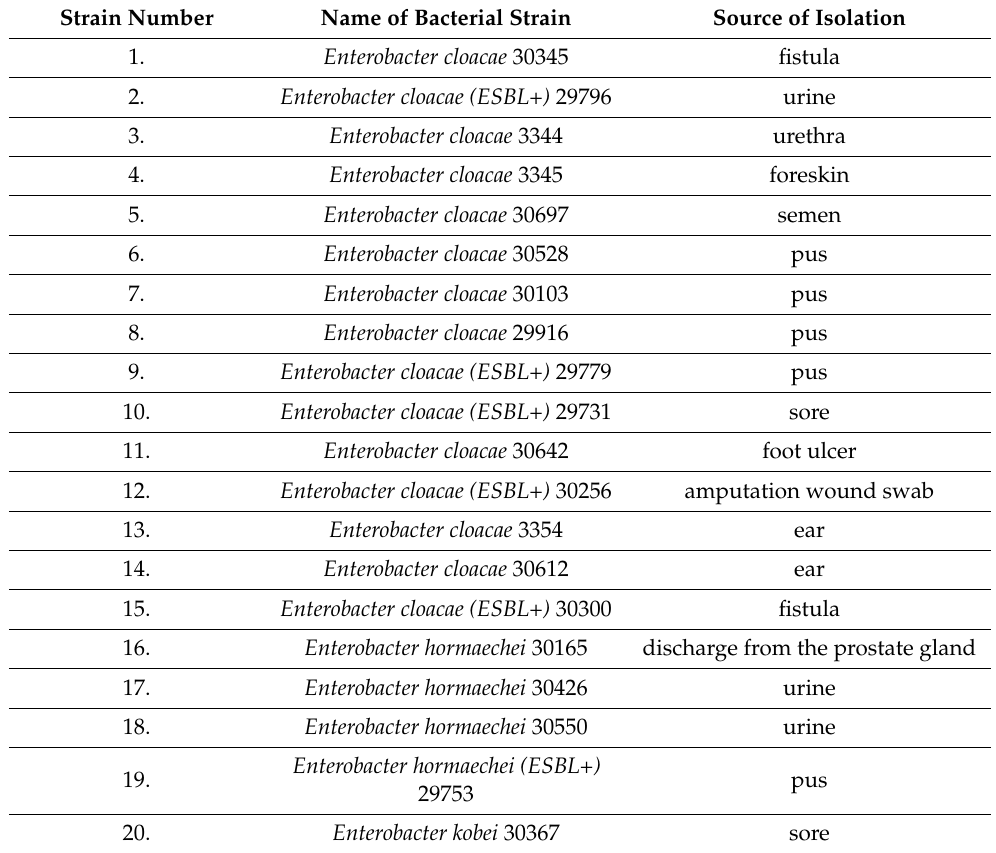
Table 1. Bacterial strains used in the experiments.